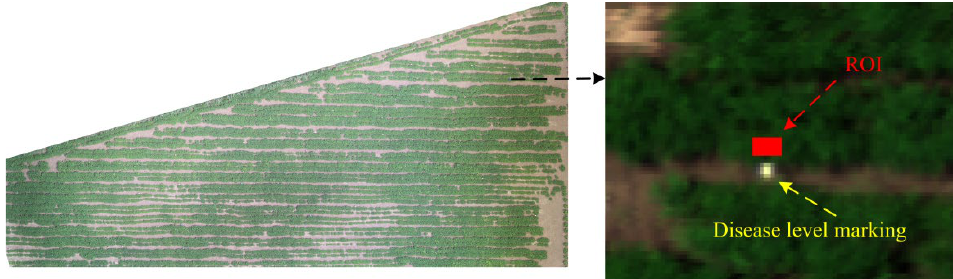
Figure 4. The hyperspectral image at the field scale and a selected ROI.